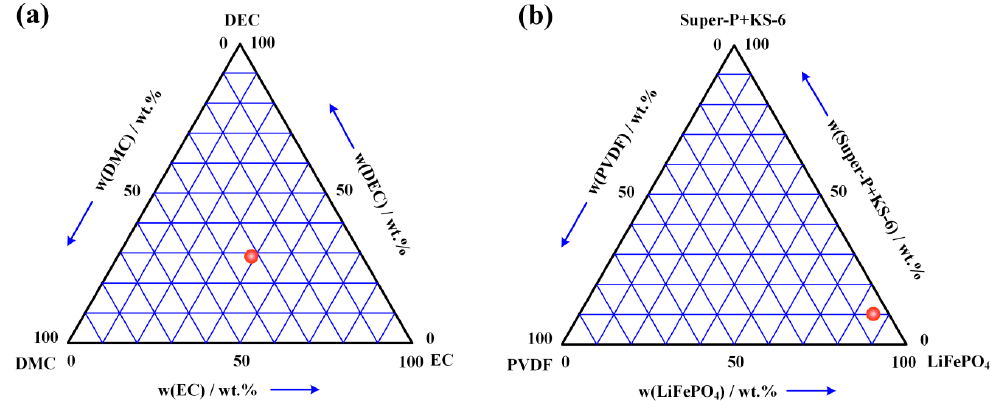
Figure 2. The volume ratio of electrolyte and positive electrode: ( a ) mixture of ethylene carbonate (EC), dimethyl carbonate (DMC) and diethyl carbonate (DEC); ( b ) mixture of LiFePO 4 , conductive carbons (Super-P Li and KS-6) and binder poly(vinylidene difluoride) (PVDF).